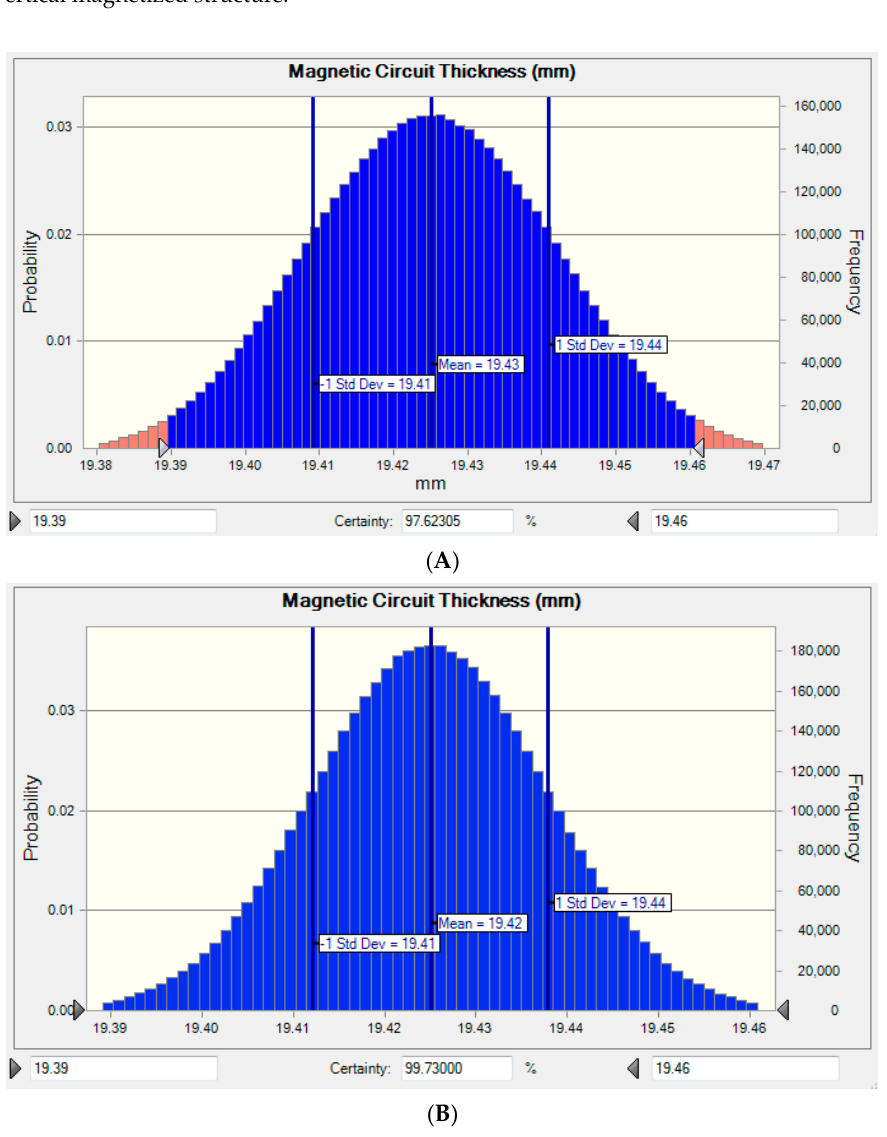
Figure 28. Optimum design of 3 sigma level by performance factor. ( A ) Minimization level of the magnetic circuit thickness level in the range of design tolerance. ( B ) Minimization level of magnetic circuit thickness level in the range of design tolerance by 3 sigma